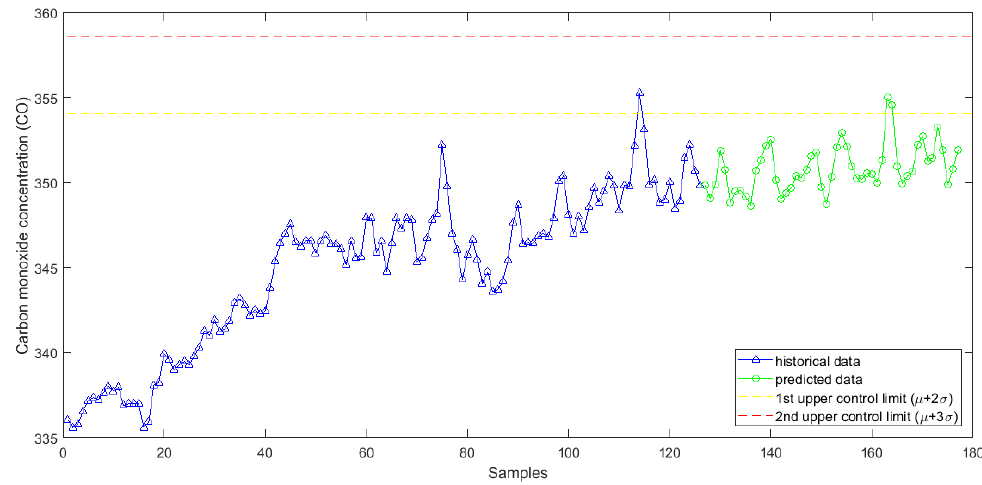
Figure 4. Multi-step ahead prediction of carbon monoxide gas concentration.